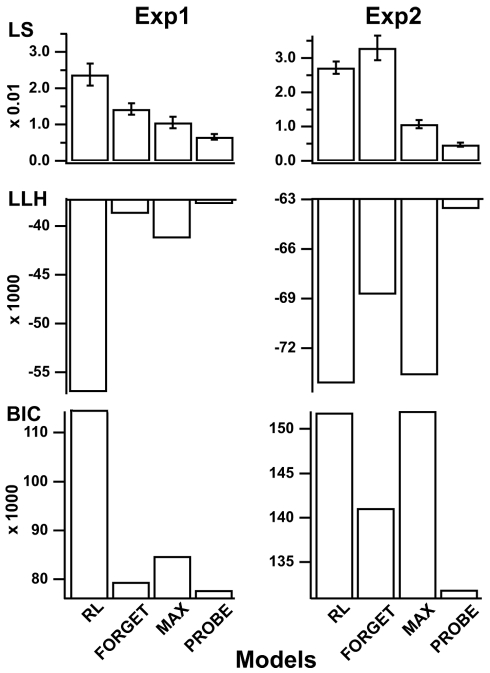
Comparison of model fits.Models were fitted using the standard maximum log-likelihood (LLH) and least squares (LS) methods. Histograms show the LS and LLH as well as the Bayesian information criterion (BIC) obtained for each model. The LLH method maximizes the predicted (log-)likelihood of observing actual participants' responses. The LS method minimizes the square difference between observed frequencies and predicted probabilities of correct responses. The Bayesian information criterion (BIC) alters LLH values according to model complexity favoring models with less free parameters (Text S1). Larger LLH, lower LS, and lower BIC values correspond to better fits. Left, first experiment with no contextual cues. Parameters that cannot be estimated (i.e., contextual learning rate αc and context-sensitivity bias δ) were removed from the fitting. RL, basic reinforcement learning model including a single task-set learning stimulus-response association (free parameters: inverse temperature β, noise ε, learning rate αs). Right, second experiment with contextual cues. RL, pure reinforcement learning model learning a mixture of stimulus-response and stimulus-cue-response associations (free parameters: inverse temperature β, β′ noise ε, learning rates αs and αc, and mixture rate ω; see Text S1). Note that in both experiments the PROBE model was the best fitting model for every fitting criterion (LS, all Fs>3.8, p<0.001).